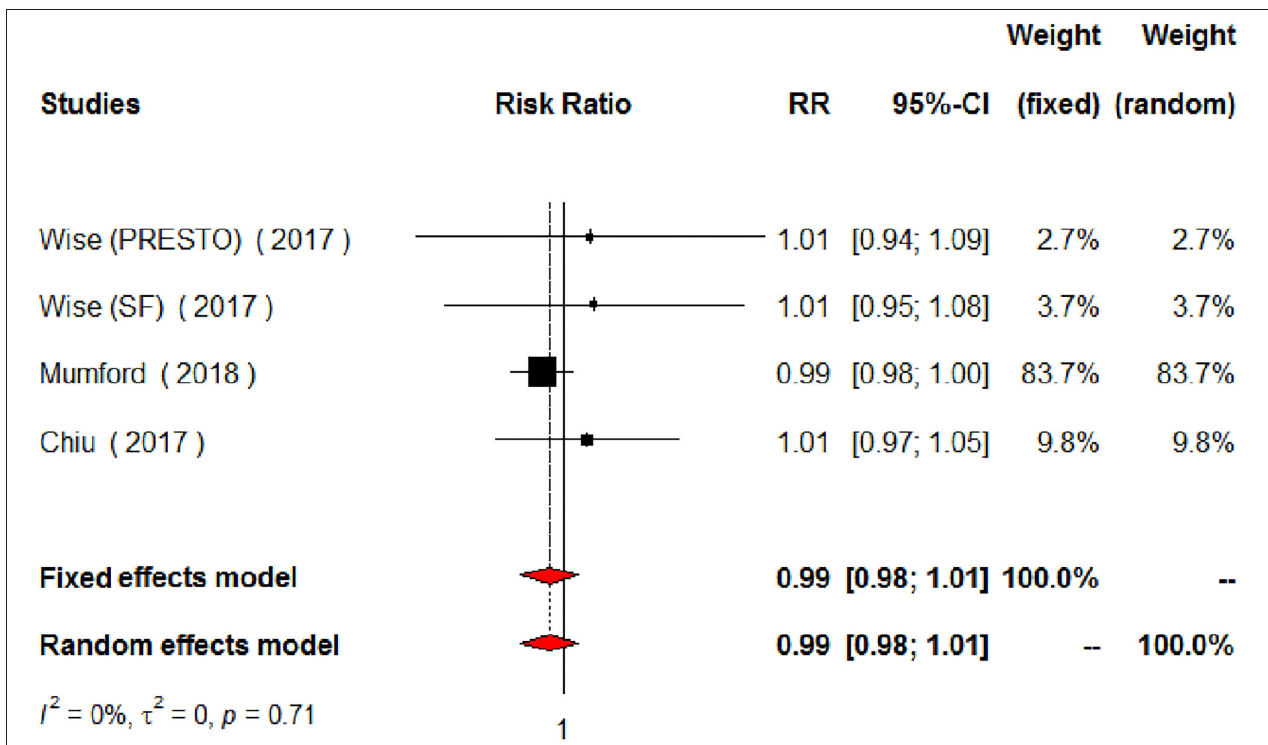
FIGURE 3 | Forest plot for the meta-analysis of the relationship between periconceptional intake of ω -6 PUFAs and pregnancy achievement ( n =